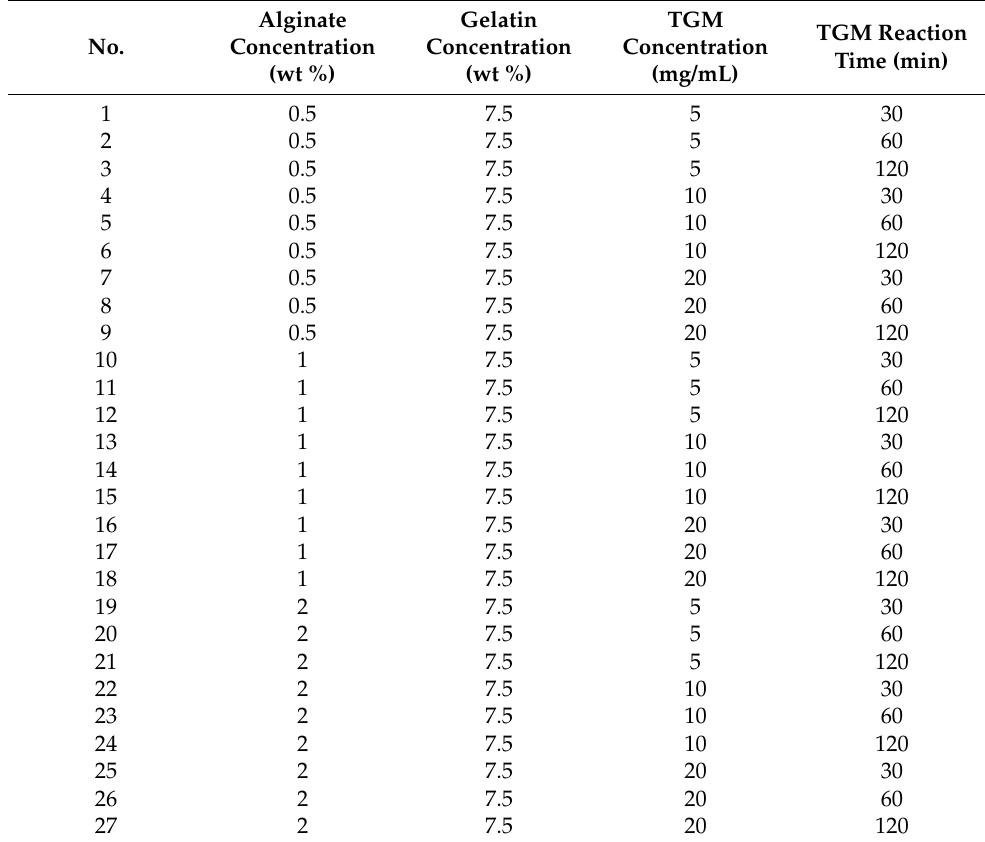
Table 1. Different parameters affecting the mechanical properties of alginate–gelatin hydrogel and tested in the present